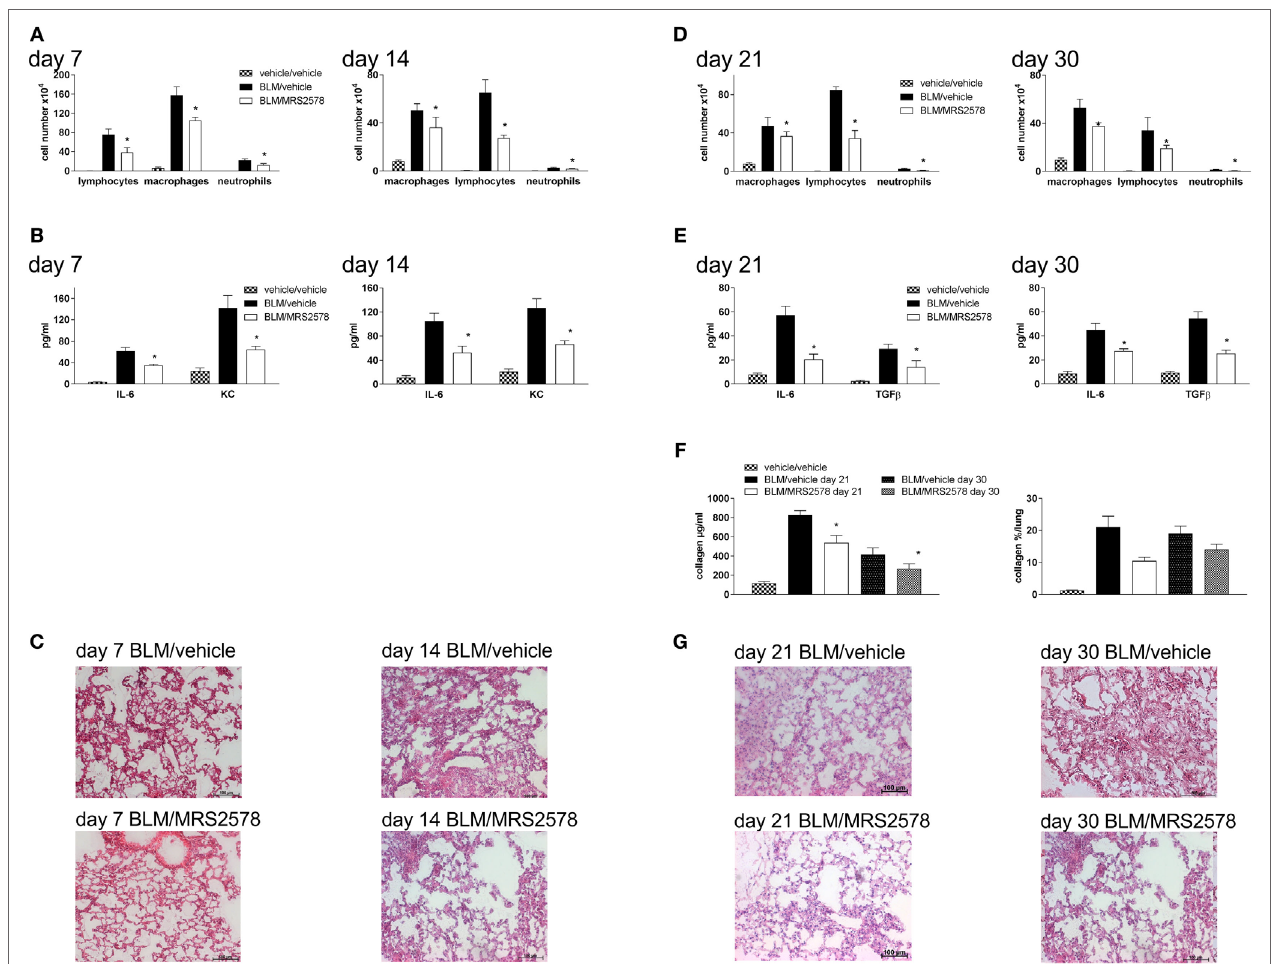
FigUre 6 | Blocking P2Y 6 R subtypes decreases bleomycin-induced pulmonary fibrosis. Male C57Bl/6 mice received an i.t. application of BLM on day 0 and were treated with the P2Y 6 R antagonist MRS2578 or vehicle according to the prophylactic (a–c) or therapeutic (D–g) protocol. Total and differential cell counts of the BALF were performed (a,D) . BALF cytokines were measured by ELISA (B,e) . Collagen contents of the BALF were quantified by Sircol assay [ (F) , left panel] or on histological lung slides [ (F) , right panel]. Representative histological staining of lung slides (c,g) . * p < 0.05 compared to BLM/vehicle-treated animals at the same time